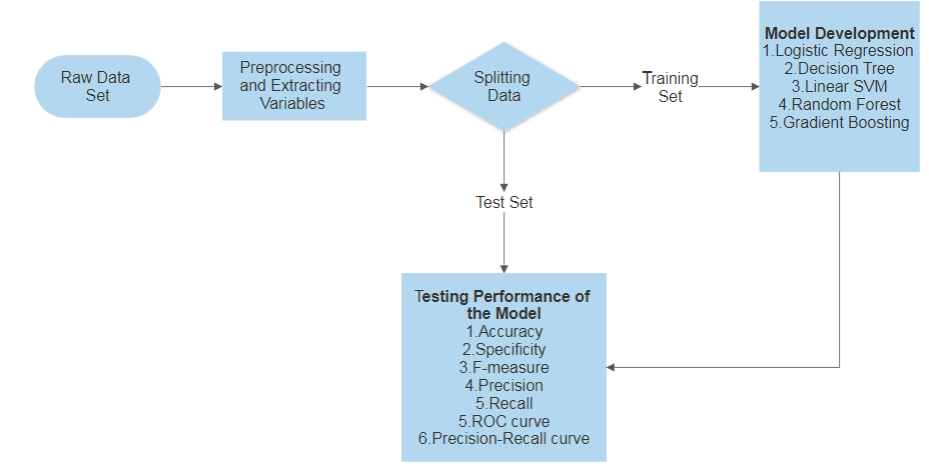
Figure 1. Framework of